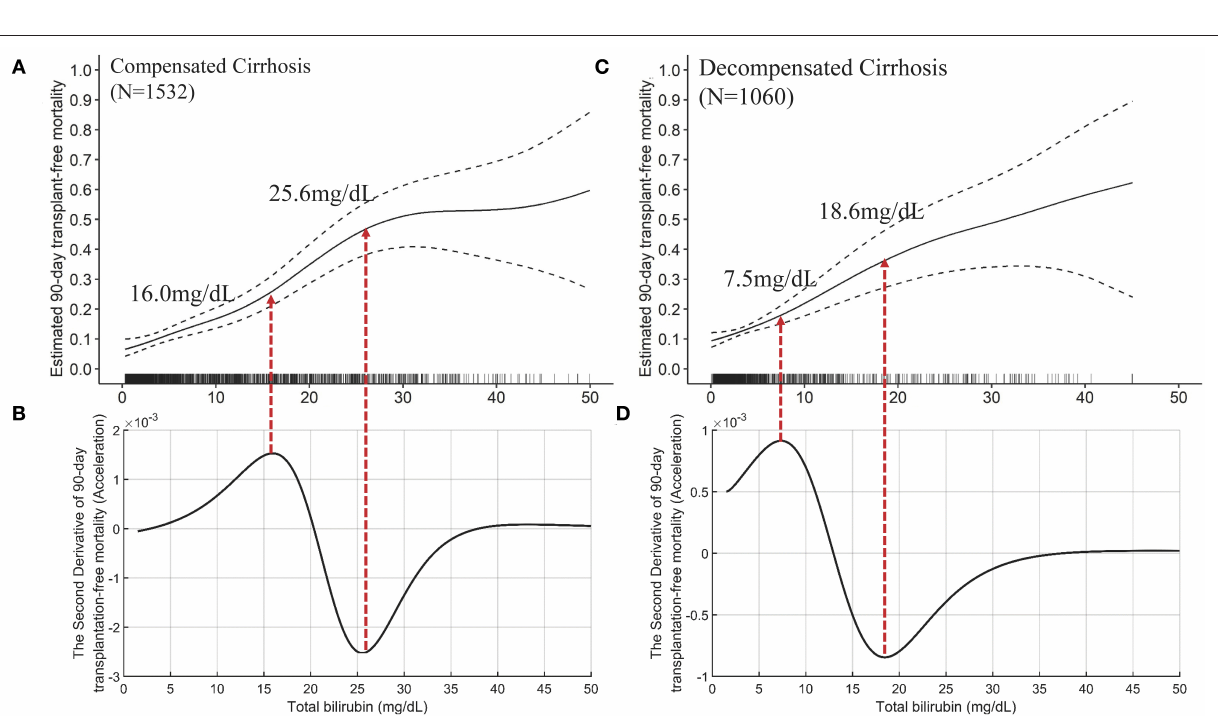
FIGURE 5 | The TB-mortality (90-day) correlation curves of compensated cirrhosis and decompensated cirrhosis and their corresponding second derivative (acceleration) curves. (A) the TB-mortality correlation curve of compensated cirrhosis; (B) the second derivative (acceleration) of TB to mortality *(compensated cirrhosis); (C) the TB-mortality correlation curve of decompensated cirrhosis; (D) the second derivative (acceleration) of TB to mortality (decompensated cirrhosis). TB, total